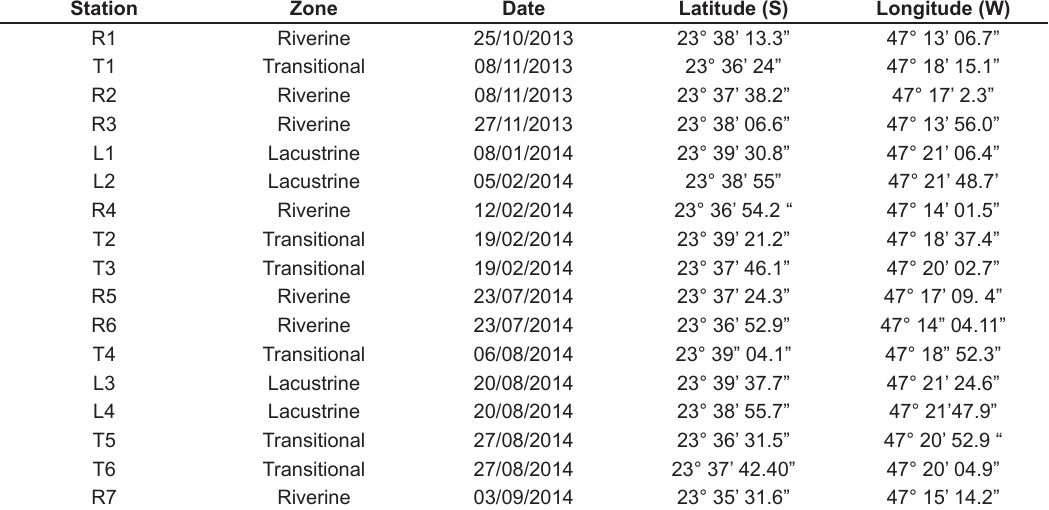
Figure 2. Sampling points localization during the spring/summer (in black) and autumn/winter (in red) respecting the particular zonation determined by Beghelli et al. (2012). L = Lacustrine zone; T = Transitional zone; R = Riverine zone. Source: Modified of Beghelli et al. (2014). Table 1. Sampling stations and their geographic